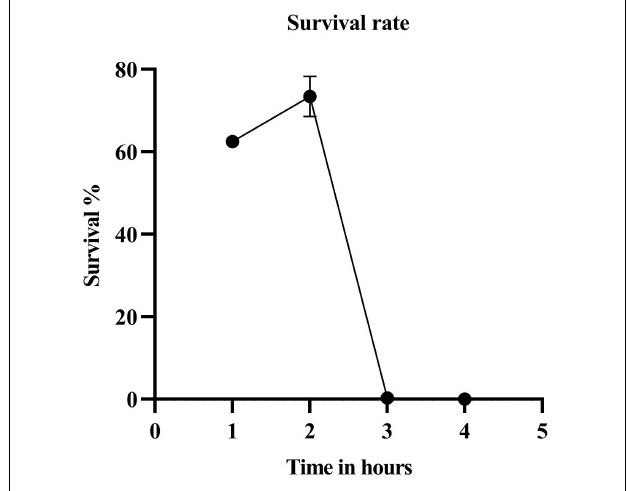
FIGURE 1 | Survival rate after EMS treatment. The survival percentage of the cells by the end of the third hour was 0.315.